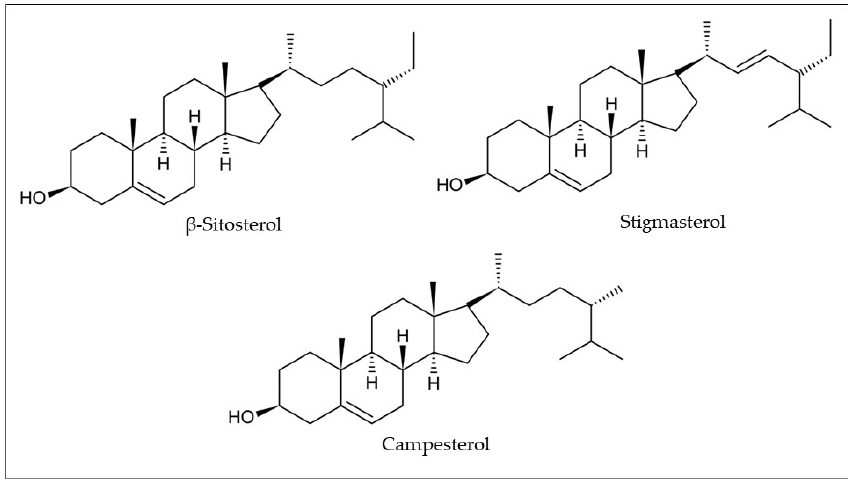
Figure 6. Chemical structures of the most common phytosterols found in araticum fruit. Own au- thorship created by ChemSketch